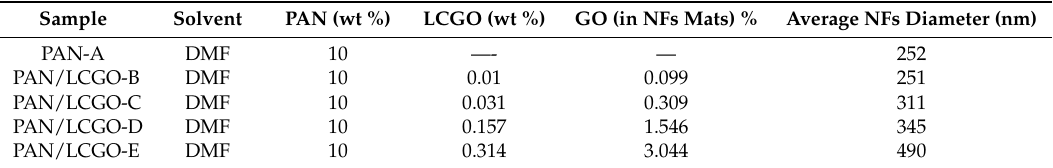
Figure 3. Field emission SEM (FESEM) images of as-spun nanofibers with different concentrations of LCGO, ( a ) PAN-A; ( b ) PAN/LCGO-B; ( c ) PAN/LCGO-C; ( d ) PAN/LCGO-D; ( e ) PAN/LCGO-E and ( f ) the high magnification FESEM image of PAN/LCGO-E to study the morphology of an individual nanofiber with highest concentration of LCGO. Table 1. Electrospinning solutions and final percentage of GO in nanofibrous (NF) mats.